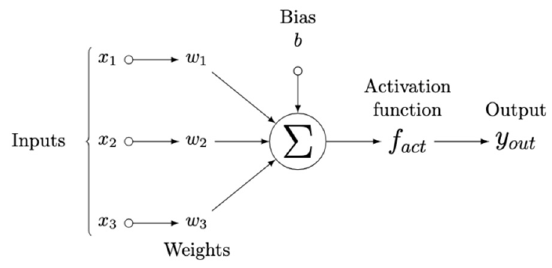
Figure 4. Schematic illustration of an artificial neuron.